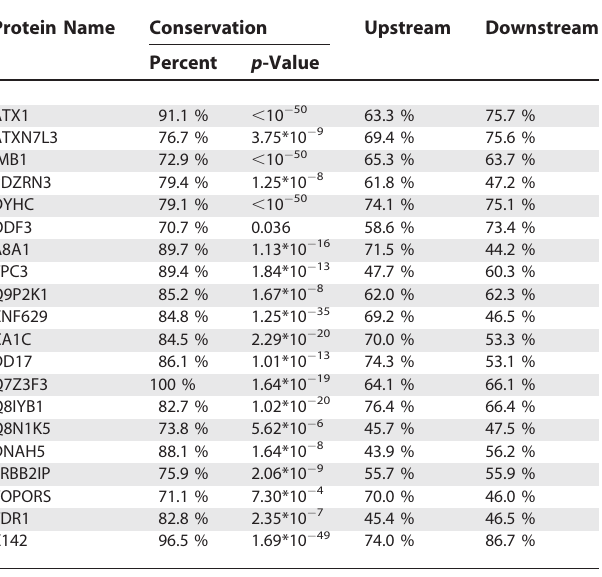
Table 5. Conservation Percentage in and around the Pseudo- gene Protein